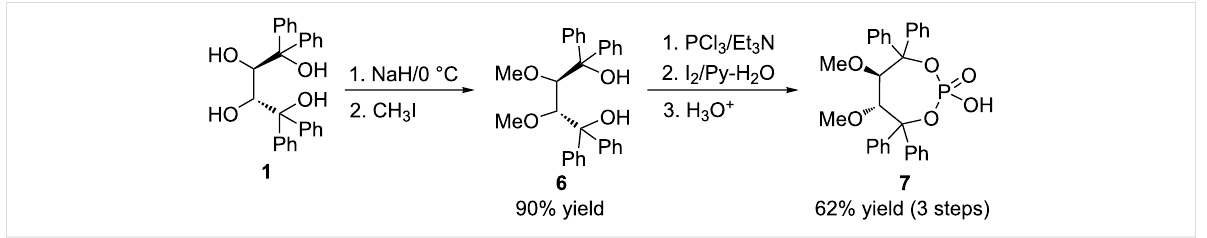
Scheme 2: Synthesis of methylated chiral phosphoric acid 7 .